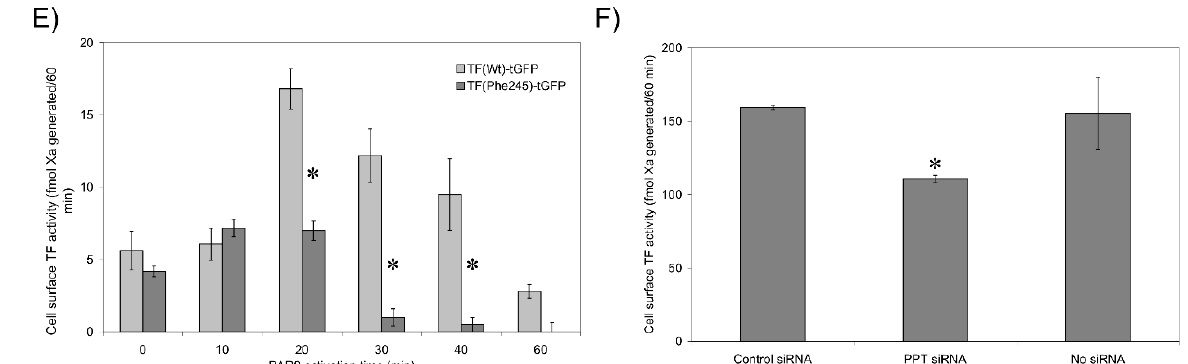
Figure 2. Analysis of TF-tGFP procoagulant activity and fVIIa-HRP binding in the presence and absence of TF palmitoylation. ( A ) HDBEC (5 × 10 4 ) were transfected with PPT-siRNA (0–15 pmol) and the expression of PPT1 and -2 measured by western blot. ( B ) HDBEC were co-transfected with combinations of pCMV-Ac-TF-tGFP and PPT-siRNA or control siRNA, and fXa-generation was measured in resting and PAR2-activated cells. ( n = 5, * = p < 0.05 vs. the respective non-activated sample.) ( C ) HDBEC were co-transfected to express TF-tGFP, with PPT siRNA or control siRNA. Factor Xa-generation was measured before and after PAR2 activation for up to 60 min. ( n = 4, * = p < 0.05 vs. the respective control siRNA sample.) HDBEC were transfected to express ( D ) TF Ser245 -tGFP or ( E ) TF Phe245 -tGFP and fXa-generation were measured as above. ( n = 6, * = p < 0.05 vs. the respective cells expressing TF Wt -tGFP.) ( F ) MDA-MB-231 (5 × 10 4 ) cells expressing endogenous TF were transfected with PPT-siRNA or control siRNA and fXa-generation measured ( n = 3, * = p < 0.05 vs. cells without siRNA).